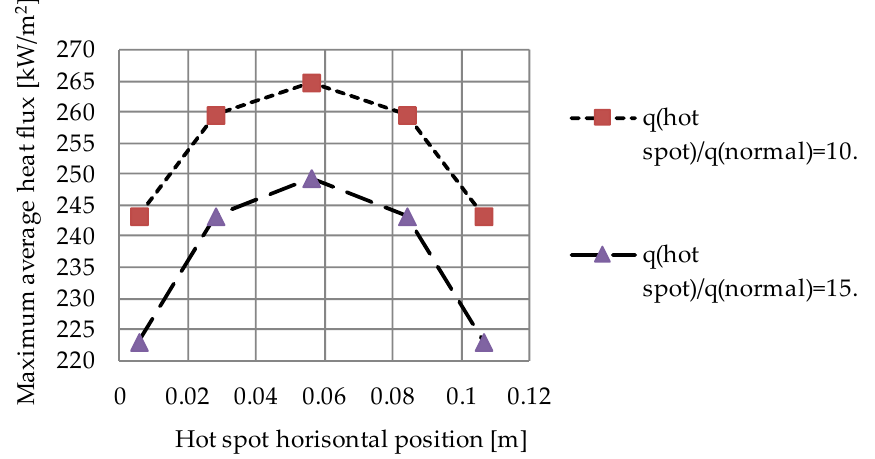
Figure 11. Maximum average heat flux for hot spots at different horizontal positions, all at top height level.